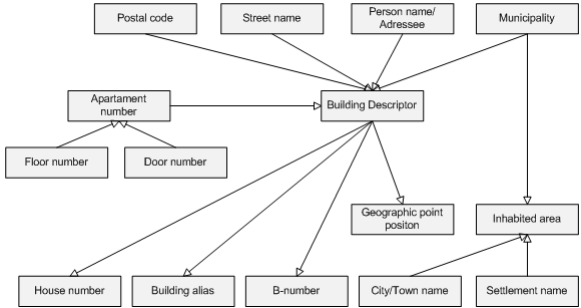
Figure 5: Causality of data dictionary represented as acyclic graph 5 LOGICAL MODEL - ENHANCED ENTITY RELATIONSHIP DIAGRAM